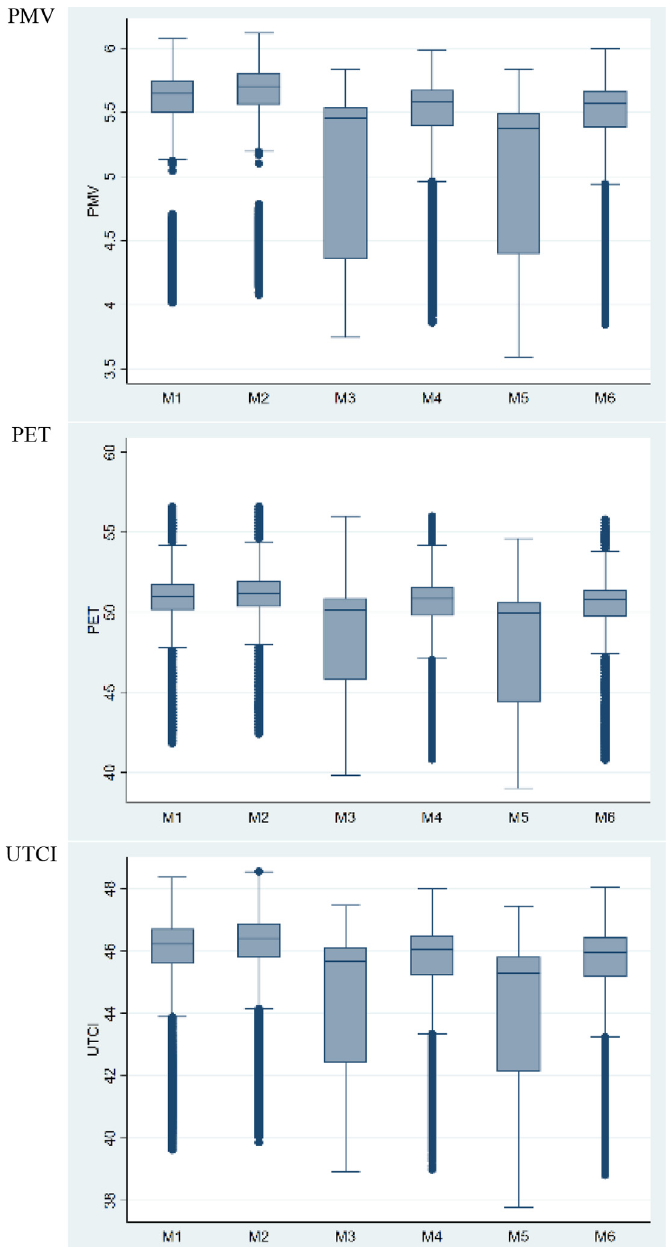
Figure 9. Simulation results of PMV, PET and UTCI under extreme heat